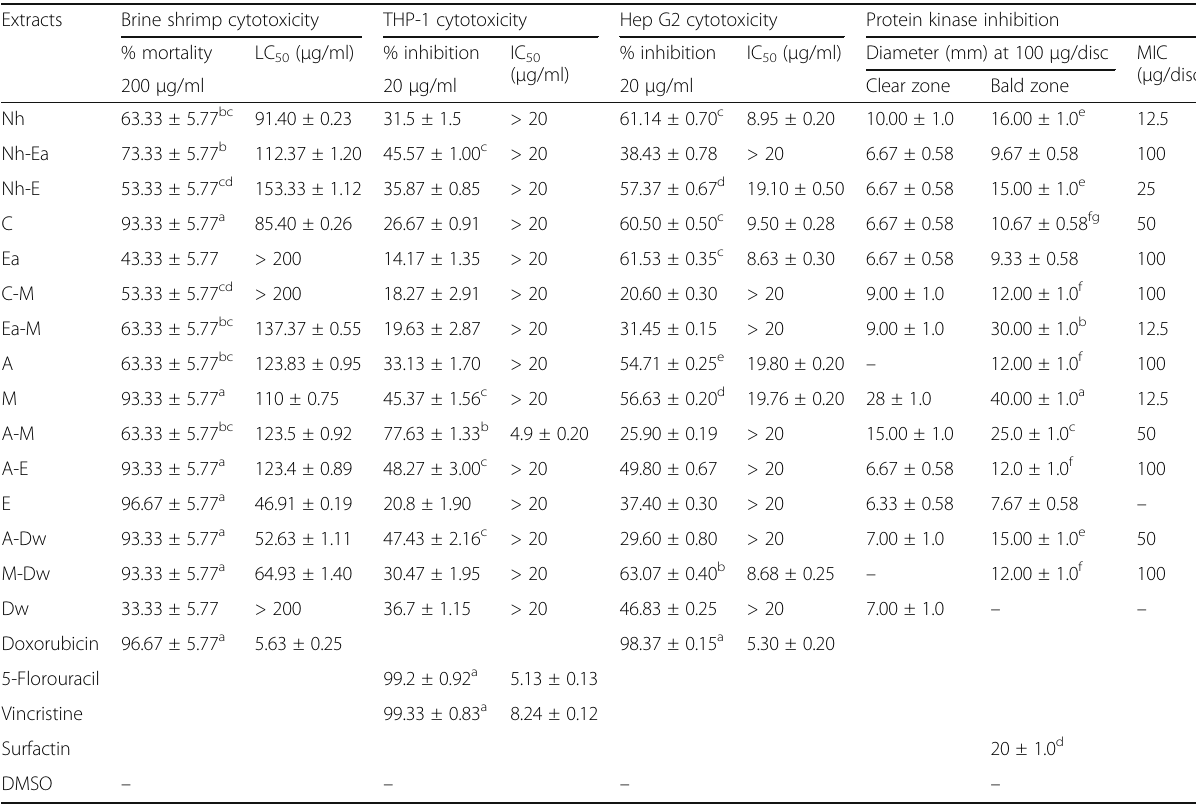
Table 2 Cytotoxicity and protein kinase inhibition of different solvent extracts of A. bracteosa Extracts Brine shrimp